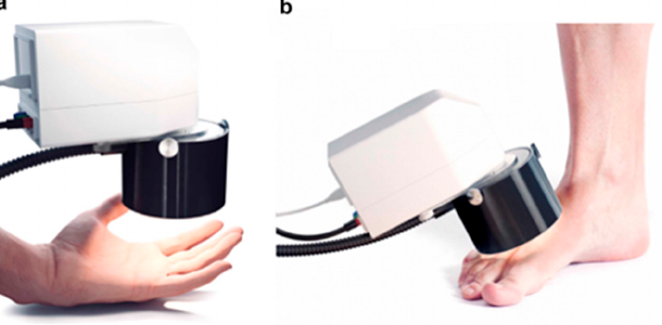
Figure 6. Compact handheld hyperspectral imaging system [61]. The proposed imaging system [67] was designed to enable quantitative diagnosis and visualization of human skin. This includes 2- dimensional mapping of skin chromophores, mapping of hemo–oxygen dynamics, and assessment of skin perfusion.